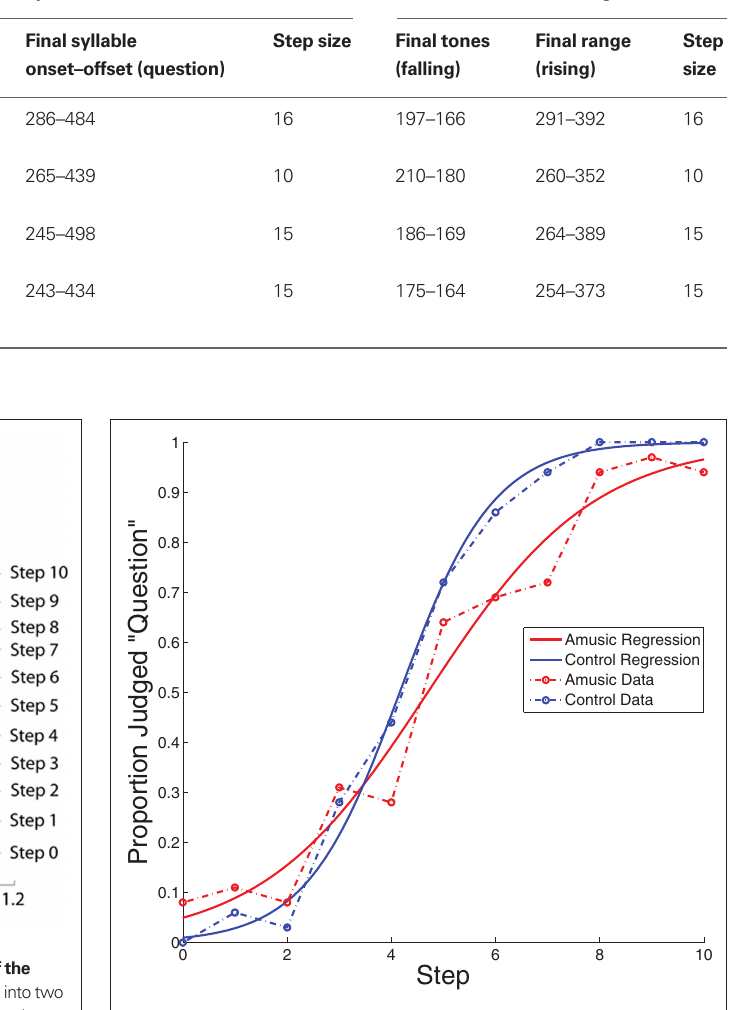
These regressions are derived from the summed data across controls and amusics, and represent a regression of the average rather than an average of individual regressions. Binomial confidence intervals are omitted here for clarity, but do not exceed ±